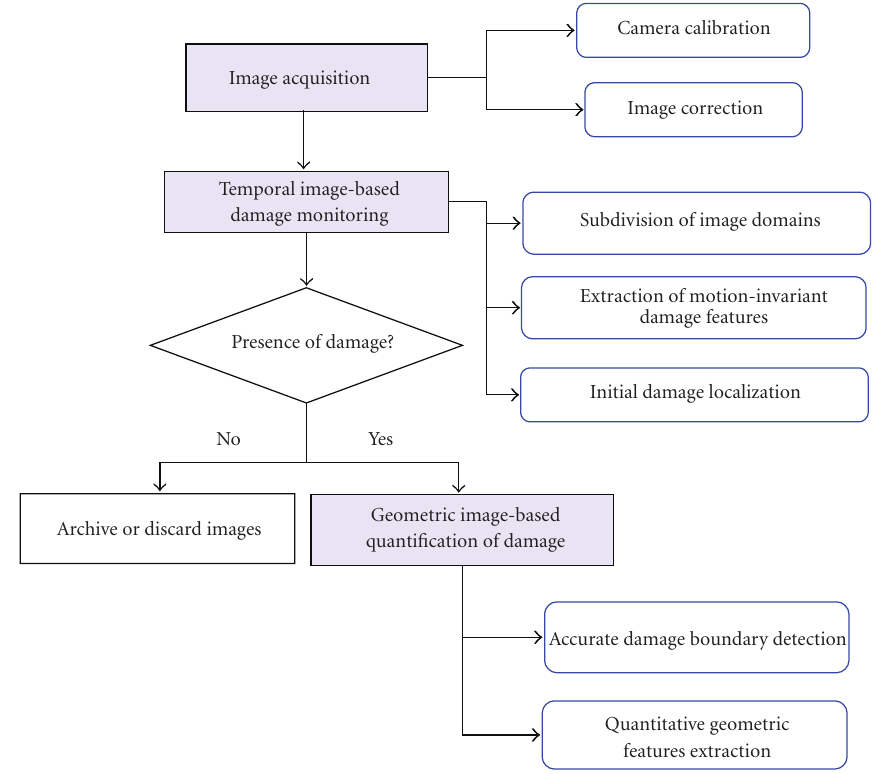
Figure 4: Proposed image-based structural damage monitoring and quantification